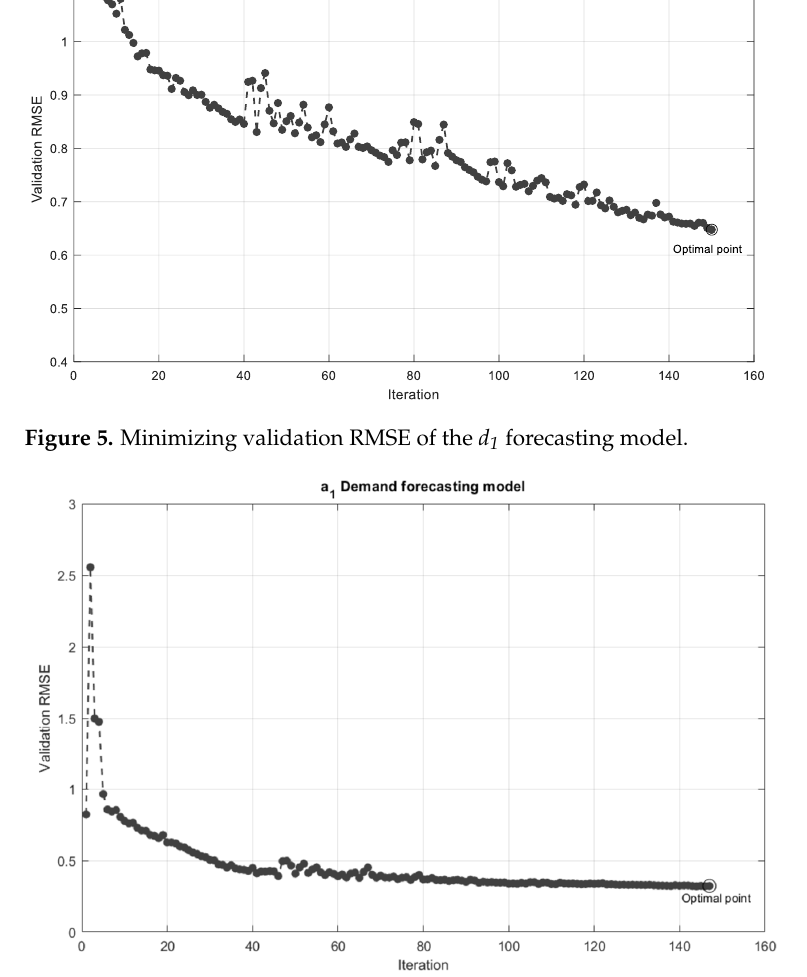
Figure 6. Minimizing validation RMSE of the a 1 forecasting model. Table 2. Optimal hyperparameters of LSTM for demand forecasting obtained by the ELATLBO.